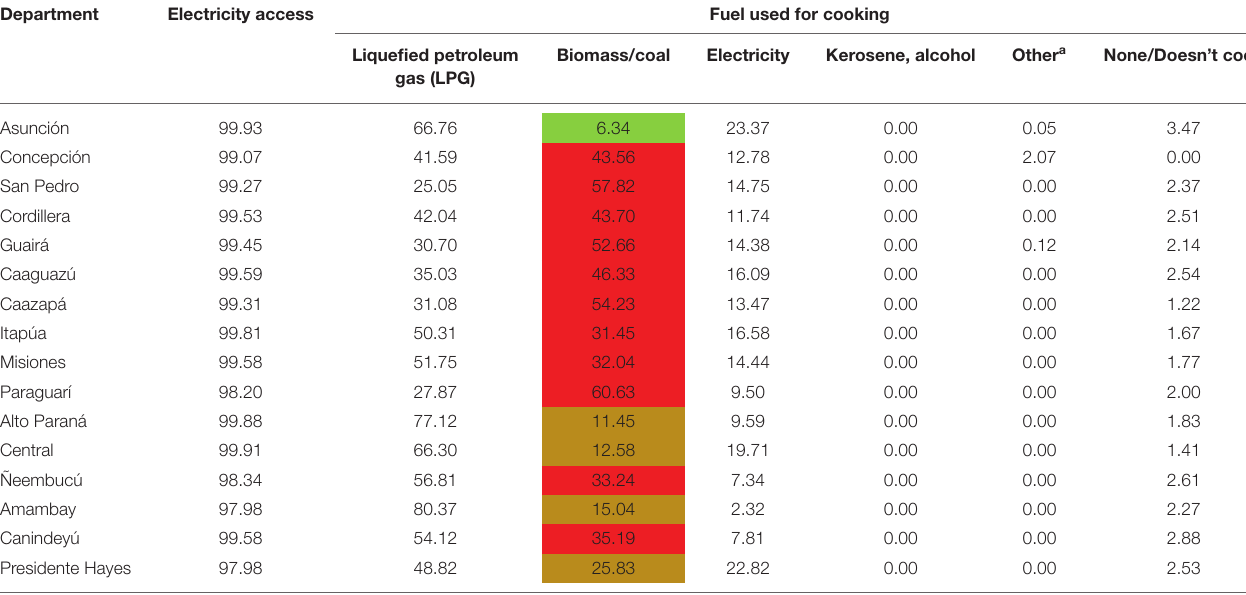
TABLE 5 | Electricity access (%) & fuel for cooking (%) - Asunción and Paraguay‘s main departments